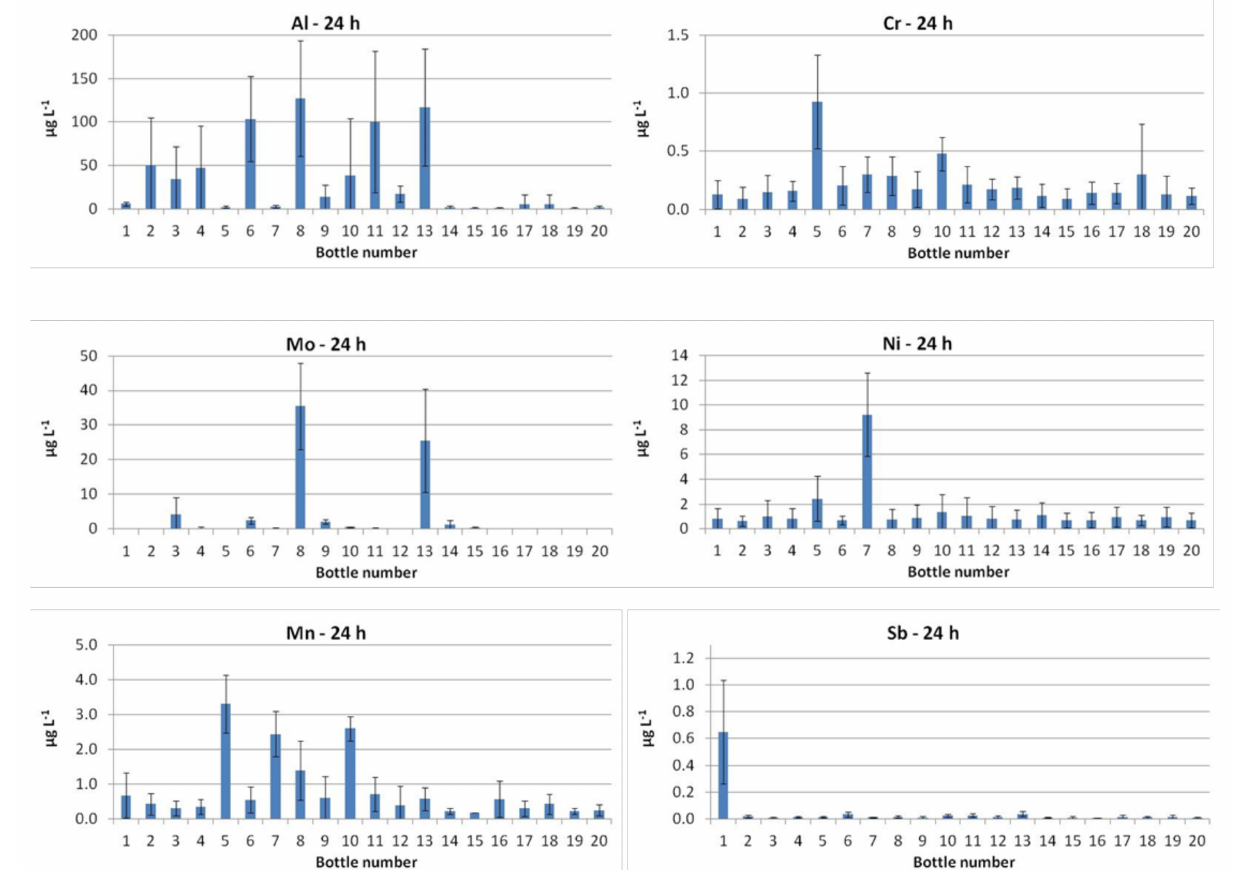
Figure 1. Mean levels of some elements in the water stored in each bottle over 24